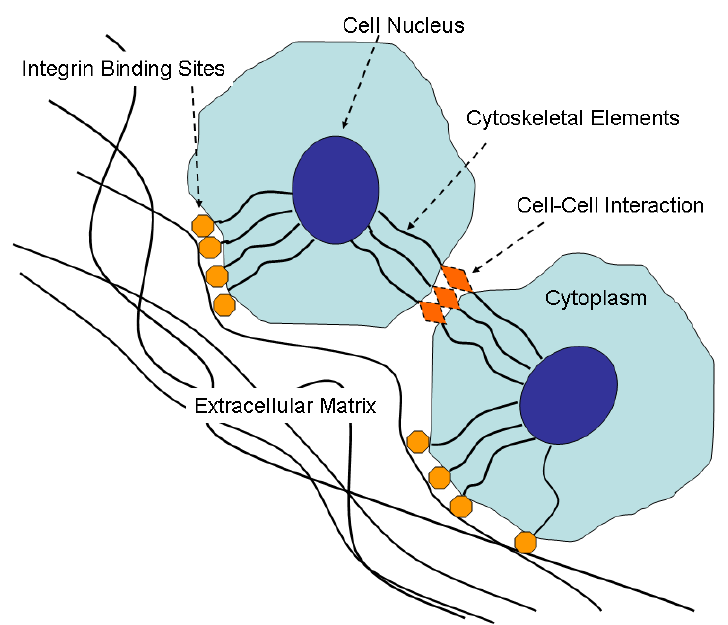
Figure 1. Diagram of cell-ECM interaction depicting integrin binding